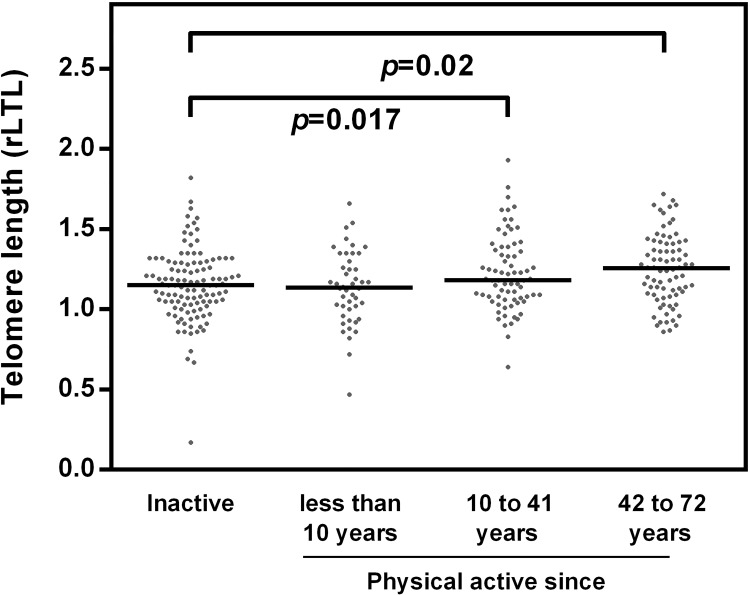
Standardized values of rLTL by exercise duration.Individuals of the different groups regarding duration since physical activity was practiced showed significant differences (p = 0.0048) in the length of telomeres (inactive group, N = 113; group active 1 to 9 years, N = 46; group active 10 to 41 years, N = 73; group active more than 41 years, N = 78). The p-value was determined conducting one-way ANOVA. The post hoc Tukey’s test revealed a significant difference between physical activity since more than 41 years and current inactivity (p = 0.017). Moreover relative telomere length of the group active more than 41 years differs significantly from the group physically active 1 to 9 years (p = 0.035).